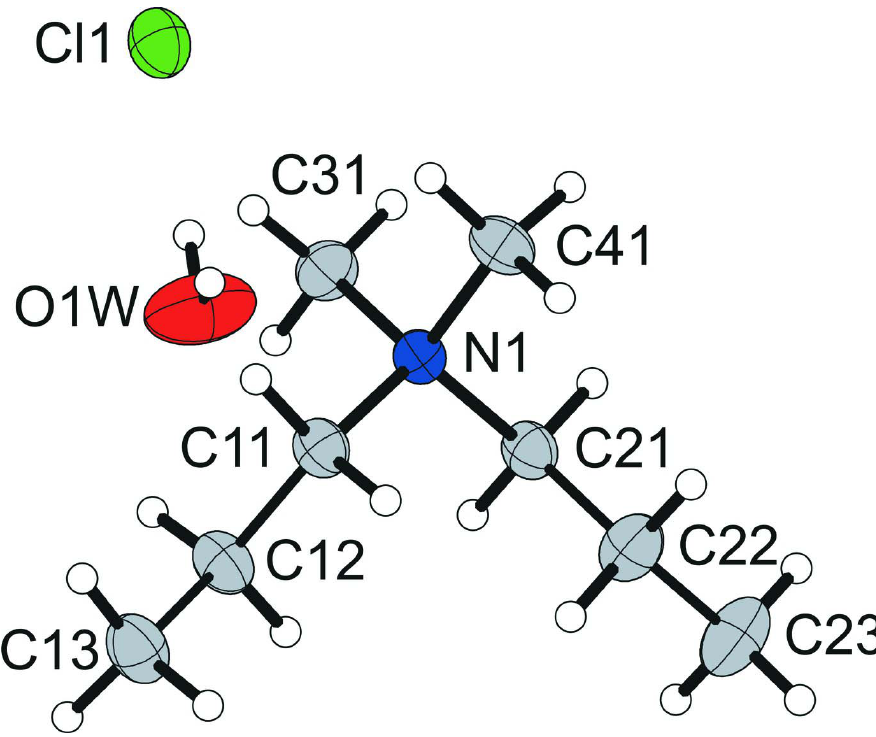
Figure 1 The molecular structure of ( 1 ) showing the atomic numbering and 50% probability displacement